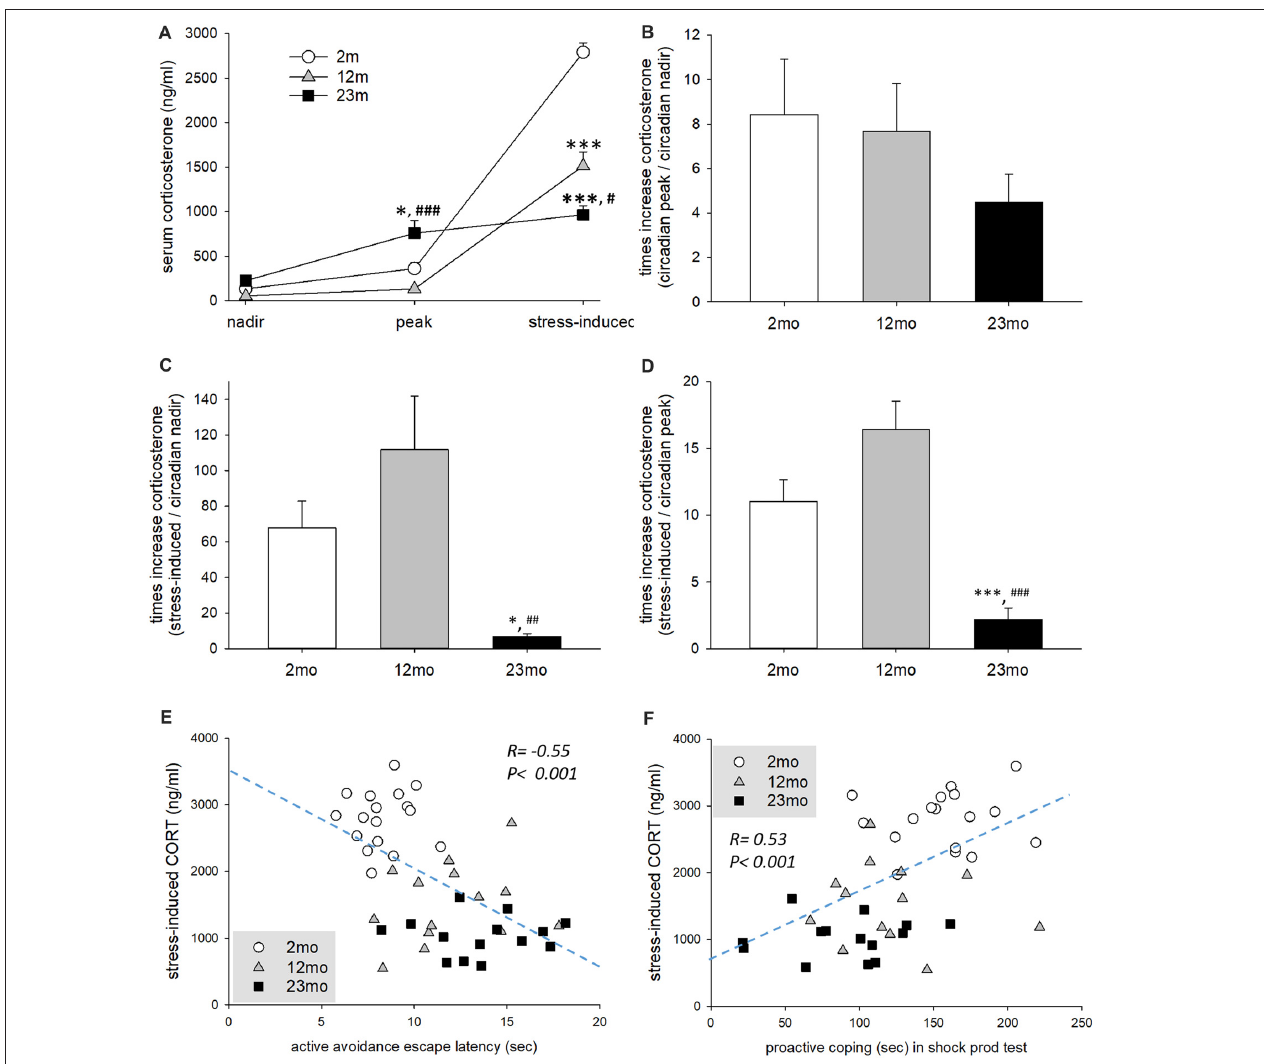
FIGURE 3 | Age-related differences in stress reactivity in relation to coping style. (A) Serum corticosterone concentration at circadian nadir and peak and after immobilization stress. Repeated measures ANOVA revealed a significant within-subject effect ( F ( 2,84 ) = 356.6, p < 0.001), between-subject effect ( F ( 2,42 ) = 17.8, p < 0.001) and within-between interaction ( F ( 4,84 ) = 60.5, p < 0.001). By pairwise comparison, the circadian peak corticosterone concentration of 23-month-old mice was higher than 2-month-old ( p = 0.017) and 12-month-old ( p < 0.001) mice. However, immobilization stress-induced corticosterone concentration of 12-month-old ( p < 0.001) and 23-month-old ( p < 0.001) mice was lower than 2-month-old mice. In addition, 23-month-old mice had lower immobilization stress-induced corticosterone concentration than 12-month-old mice ( p = 0.02). (B) Fold change of circadian peak vs. circadian nadir corticosterone concentration. There was no significant difference among age groups ( F ( 2,38 ) = 1.0, p = 0.376). (C) Fold change of stress-induced vs. circadian nadir corticosterone concentration. There was a significant group difference ( F ( 2,38 ) = 7.2, p = 0.002), and fold change was decreased in 23-month mice compared to 2-month ( p = 0.045) and 12-month ( p = 0.002) mice. (D) Fold change of stress-induced vs. circadian peak corticosterone concentration. There was a significant group difference ( F ( 2,38 ) = 19.2, p < 0.001), and fold change was decreased in 23 month mice compared to 2 month and 12 month ( p < 0.001) mice. (E) Correlation of escape latency in active avoidance test and stress-induced corticosterone concentration. Pearson’s correlation coefficient was − 0.55 ( p < 0.001). (F) Correlation between proactive coping behaviors in the shock prod test and stress-induced corticosterone concentration. The Pearson correlation coefficient was 0.53 ( p < 0.001). All data are the mean ± SEM. 2 mo: 2-month old ( n = 17), 12 mo: 12-month old ( n = 14), 23 mo: 23-month old ( n = 15). ∗ p < 0.05, ∗∗∗ p < 0.001 vs. 2 mo, # p < 0.05, ## p < 0.01, ### p < 0.001 vs. 12